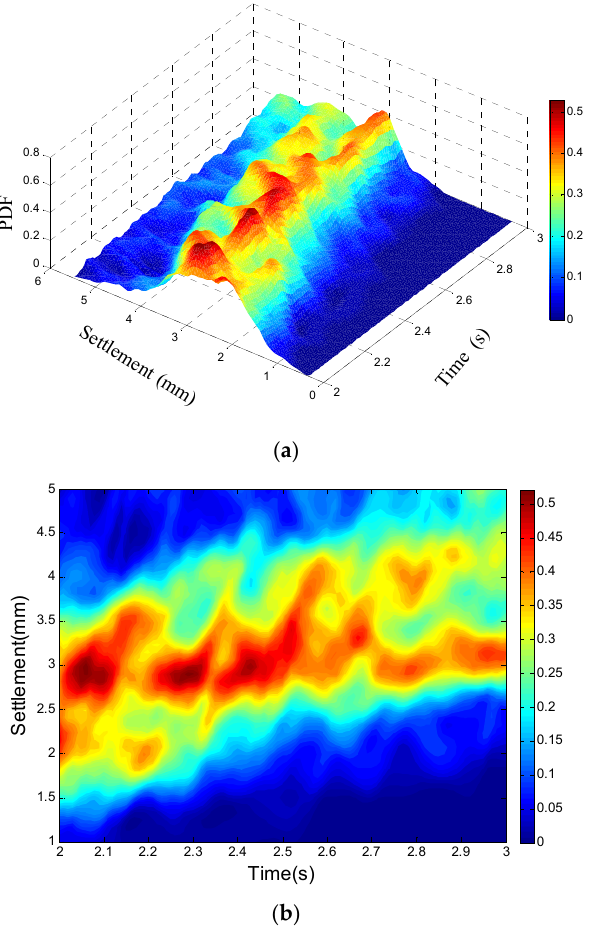
Figure 14. ( a ) Settlement PDF surface and ( b ) PDF contour at a time interval of 2~3 s at the RC pile head.